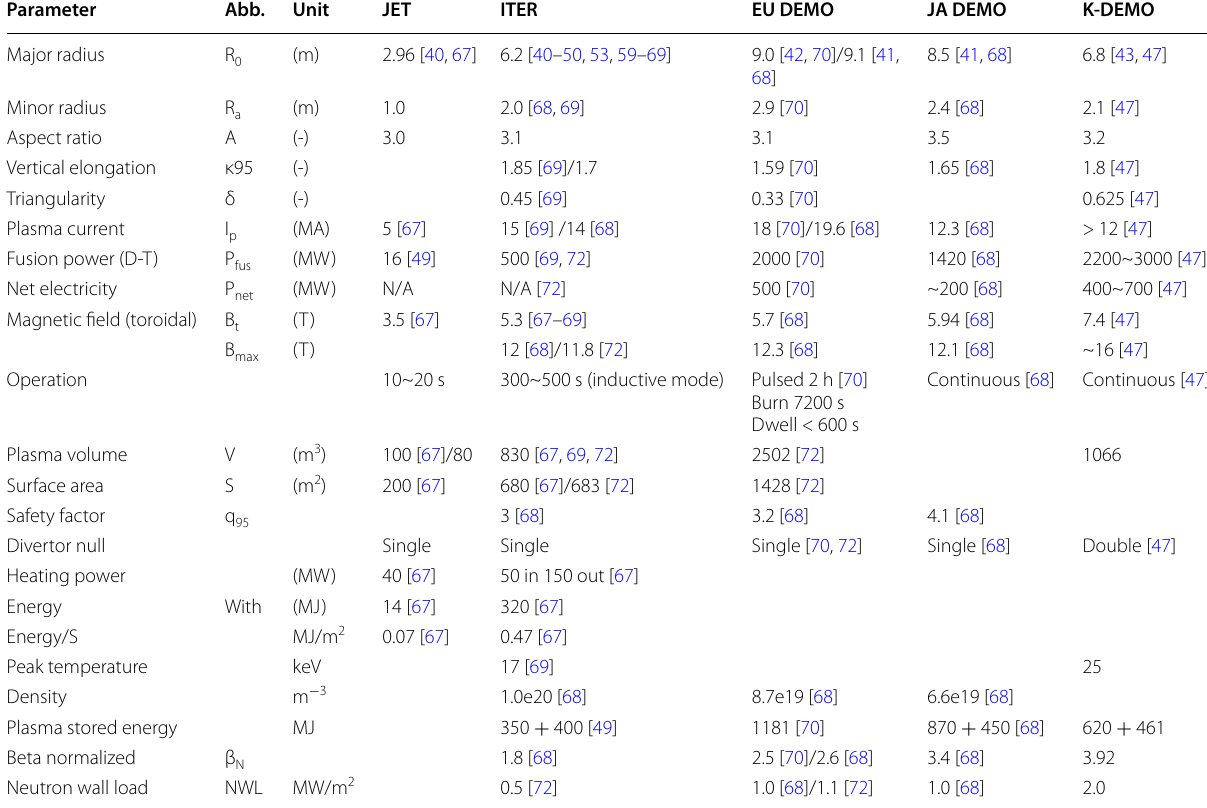
Table 1 Key design factors of major fusion machines and DEMO reactors [47, 49,